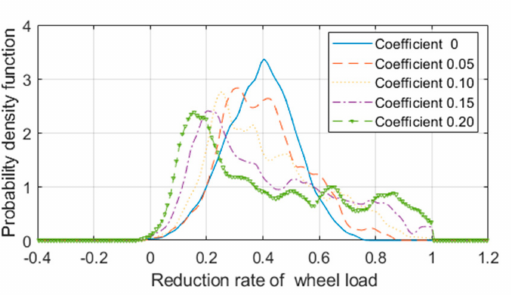
Figure 14. Probability density diagram of the reduction rate of wheel load for different variation